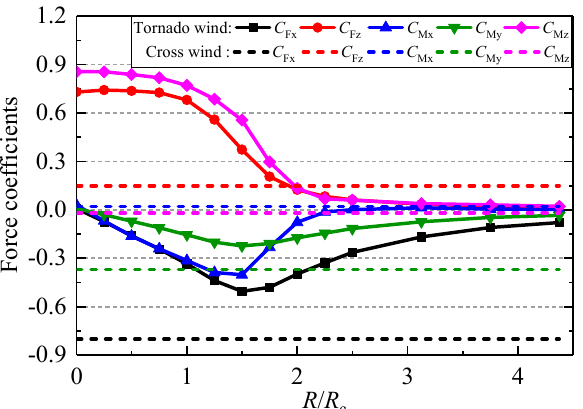
Figure 18. Variations in the wind force coefficients with the distance between car and the tornado’s center ( S = 0.35, λ = 0).